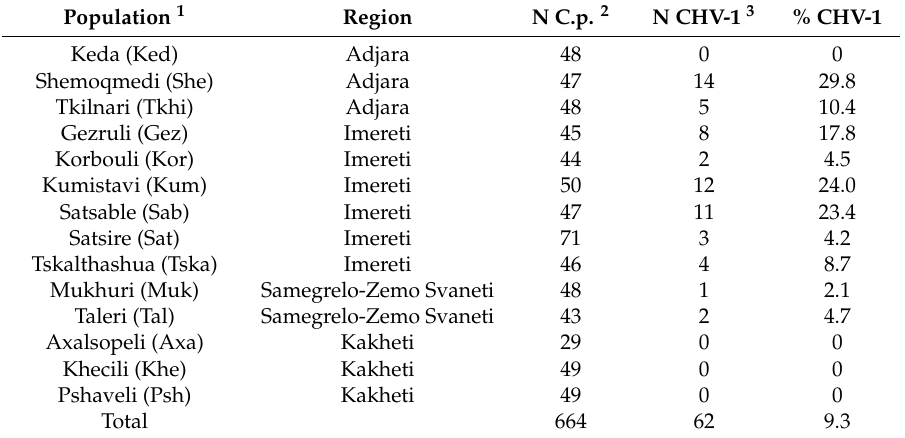
Table 1. Prevalence of CHV-1 in the Cryphonectria parasitica populations sampled in